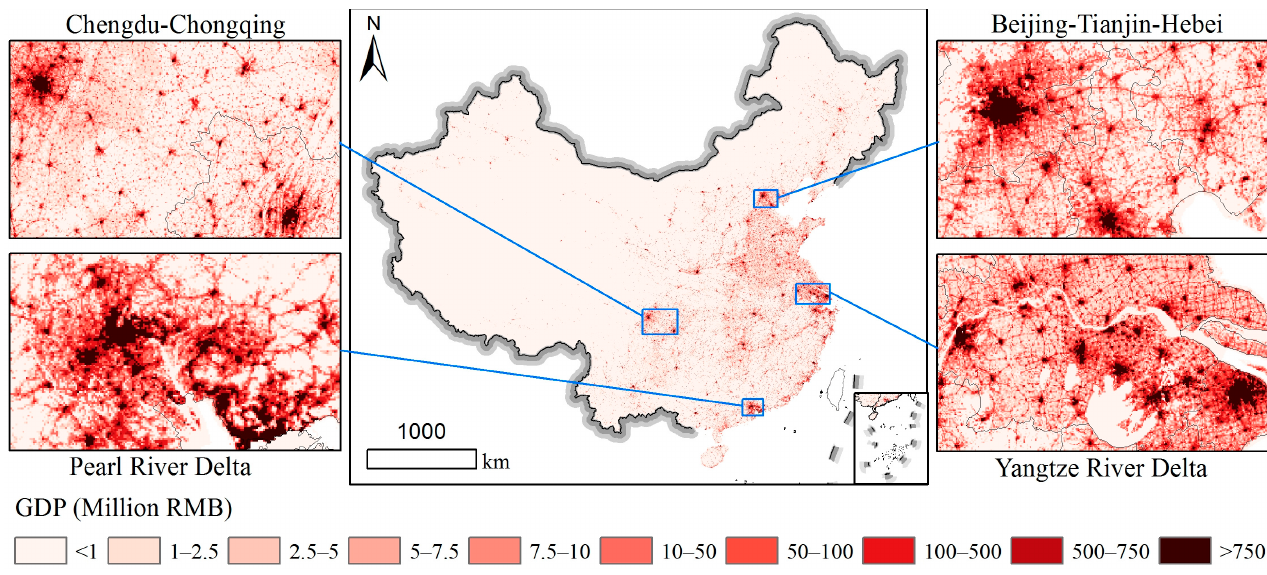
Figure 9. The 1 km gridded GDP map of China for the tertiary sector.